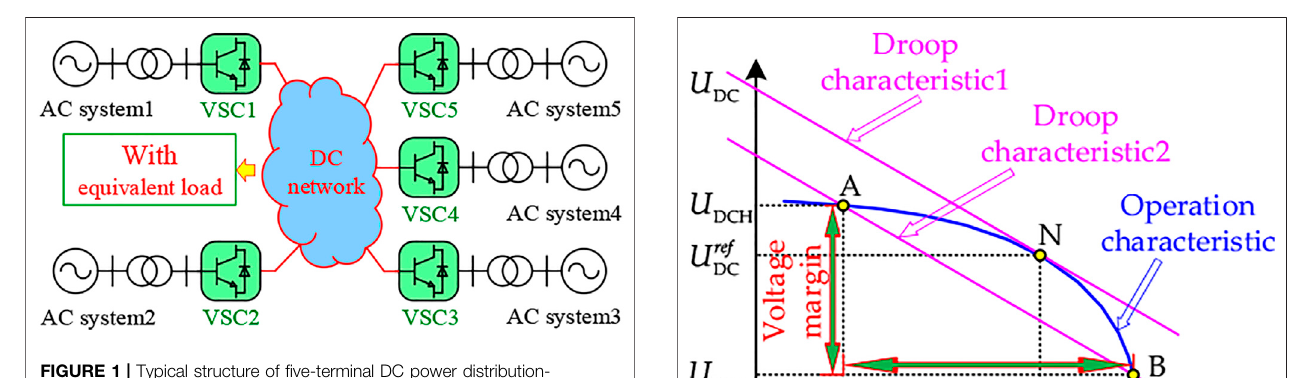
FIGURE 1 | Typical structure of fi ve-terminal DC power distribution- based VSC.